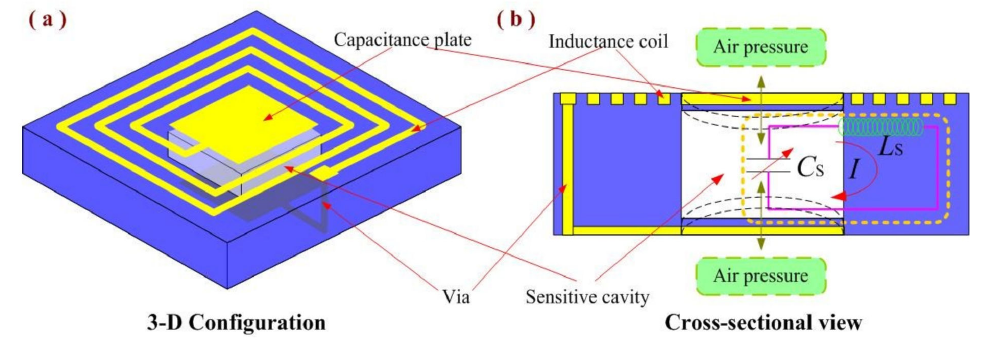
Figure 1. Structure of the wireless passive LC pressure sensor with the sensitive cavity. ( a ) Design schematic of the 3D configuration; ( b ) Cross-sectional view of the passive LC pressure